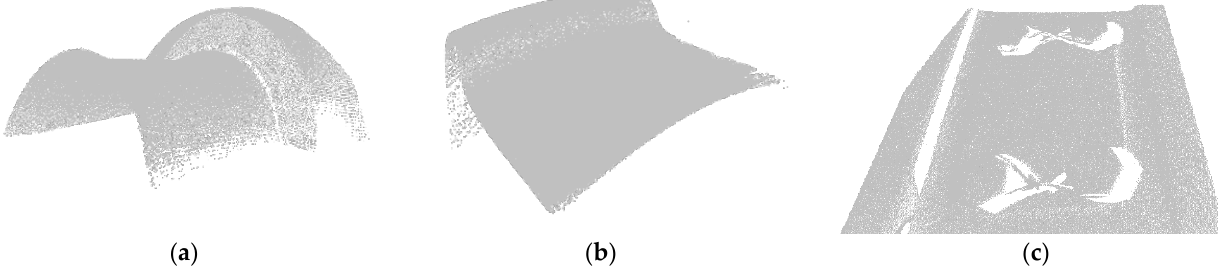
Figure 5. Experimental data of real point cloud in railway transportation. ( a ) Train wheel tread data 1, ( b ) train wheel tread data 2, and ( c ) bolt components.